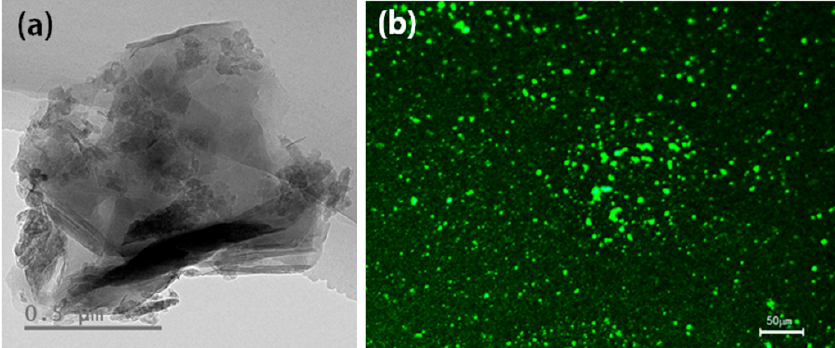
Figure 3. ( a ) TEM image of Ce-T / M powder and ( b ) fluorescence microscope (FM) image of 5 wt % Ce-T / M modified bitumen.